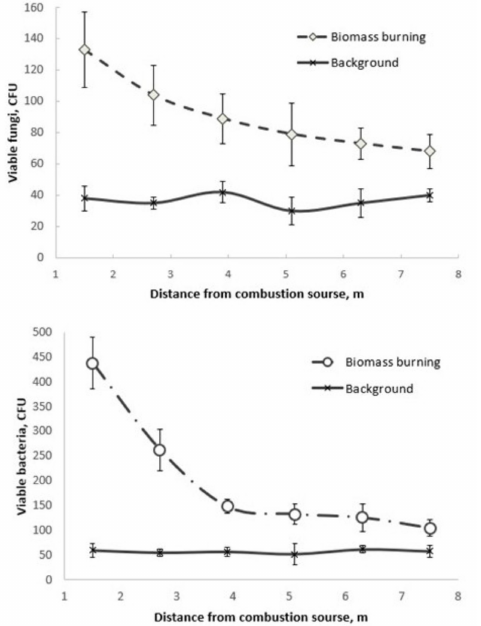
Figure 5. Relationships between the concentration of viable bacteria ( a ) and fungi ( b ), in the Dirranbandi series of experiments, and the distance from the fire. Error bars show the standard deviation of three experimental repeats for both, background and burning related